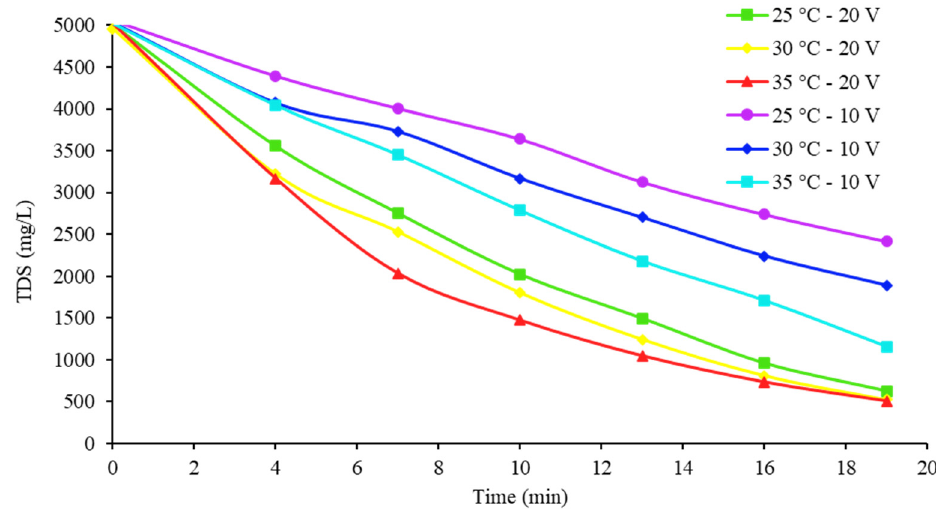
Figure 10. Desalination of the 2000 mg/L TDS samples at the chosen temperatures and initial con- centrations.